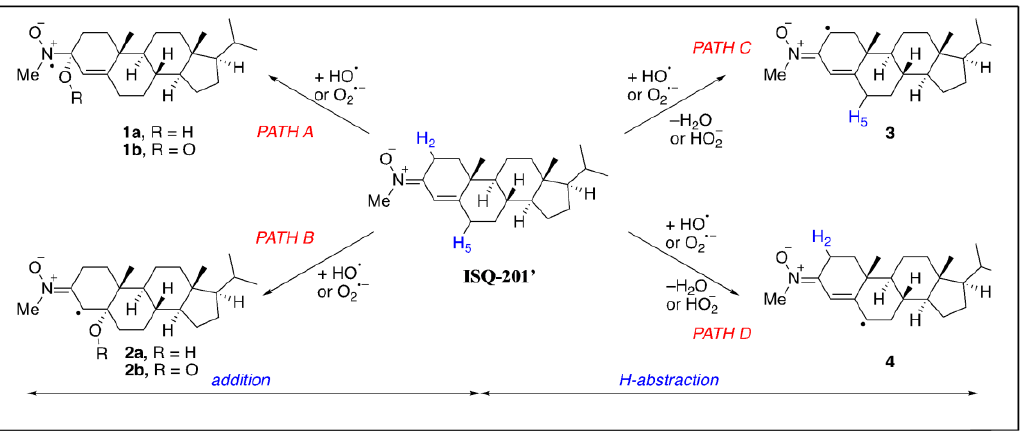
Table 1. Computed free reaction energies (∆G R , at 298 K, in kcal/mol) for the reactions involving ISQ-201’ and radicals HO • and O 2•– . All data were computed at the polarizable continuum method (PCM)(water)–B3LYP-D3/def2-TZVPP//B3LYP-D3/def2-SVP level.